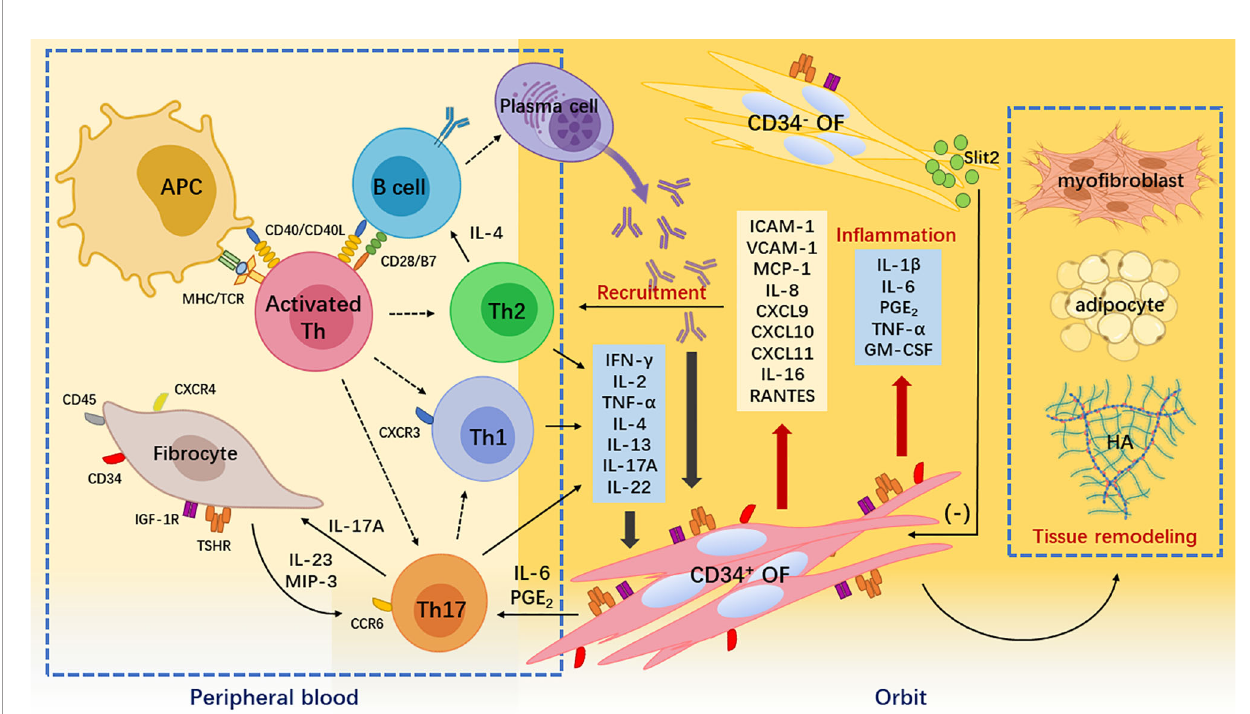
FIGURE 1 | Pathogenesis of Graves ’ orbitopathy. Breakdown of self-tolerance to thyroid-stimulating hormone receptor (TSHR) leads to the recognition of TSHR epitopes by antigen-presenting cells and B cells. They process the TSHR peptides to activate naïve T helper (Th) cells. Activated and expanded naïve Th cells differentiate into different subsets including interferon (IFN)- g -producing Th1 cell, interleukin (IL)-4-producing Th2 cells, and IL-17A-producing Th17 cells. These cytokines together with autoantibodies produced by plasms cells derived from self-reactive B cells stimulate orbital fi broblasts (OFs), thereby initiating in fl ammatory responses in the orbit. IFN- g is cytotoxic, IL-4 helps B cell expansion and autoantibody class switching, and IL-17A is proin fl ammatory and pro fi brotic. Meanwhile, peripheral CD34 + fi brocytes in fi ltrate orbital connective tissues and transition into CD34 + OFs. Upon IFN- g and IL-17A stimulation, these CD34 + cells not only robustly produce chemokines such as C-X-C motif ligand 9/10/11 attracting C-X-C chemokine receptor 3 + Th1 cell and macrophage in fl ammatory protein-3 attracting C-C chemokine receptor 6 + Th17 cells but also secrete a large amount of cytokines such as IL-1 b and prostaglandin E 2 that exacerbate orbital in fl ammation. CD34 + OFs ultimately synthesize hyaluronic acid and differentiate into adipocytes or myo fi broblasts that cause orbital tissue remodeling. The orbital native residential CD34 - OFs express immunomodulatory molecules such as Slit2 to restrain the activities of the in fi ltrating CD34 +